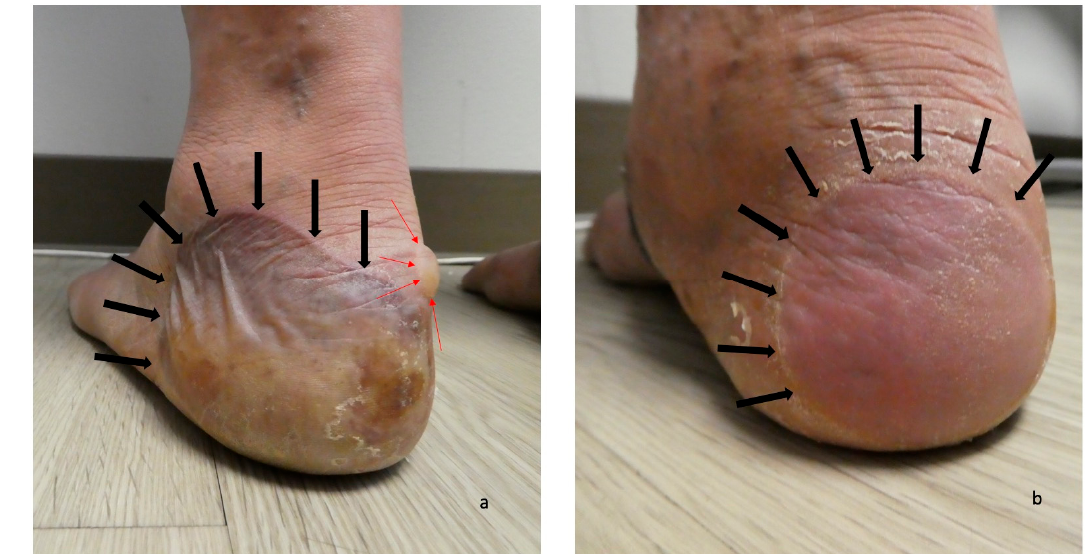
Figure 1. Dyshidrosiform bullous pemphigoid presenting as plantar blisters. A tender large flaccid hemorrhagic blister ( a ) and a flattened blister ( b ) on the posterior and plantar left heel ( a ) and right heel ( b ) of a 61-year-old man are the initial clinical manifestations of dyshidrosiform bullous pemphigoid. The blisters are outlined by black arrows; a tense, clear fluid-containing blister (outlined in red arrows) is also present on the medial area of the left heel ( a ). The figure and legend were originally published in Cureus under the Creative Commons (CC-BY): https://creativecommons.org/licenses/ on 11 January 2020 (Cohen PR: Dyshidrosiform bullous pemphigoid: Case reports and review. Cureus. 2020 Jan 11:12(1):e6630) and are republished with permission.